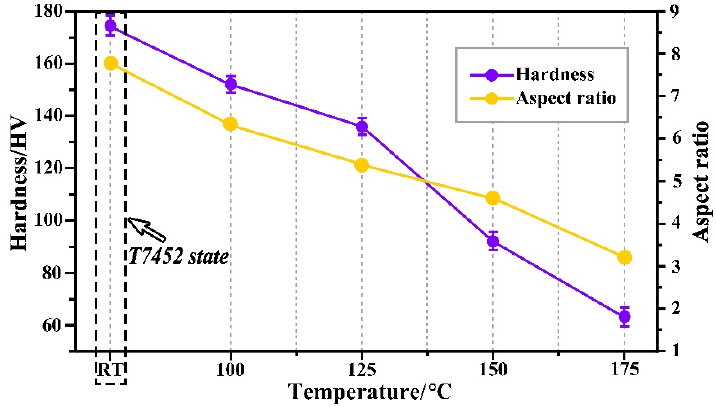
Figure 11. Comparison of the average aspect ratio–temperature curve with the hardness-temperature curve.